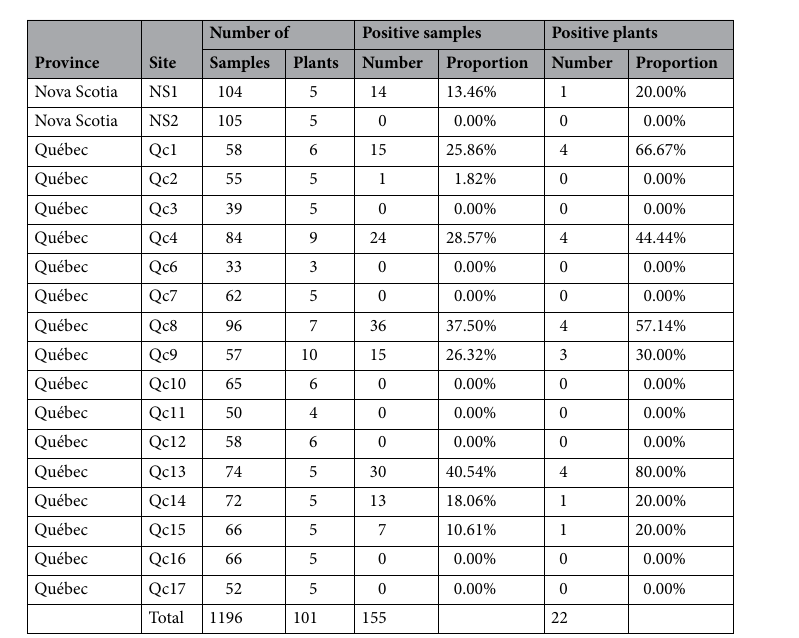
Table 5. Summary of BBSP LAMP assay results on field samples collected in